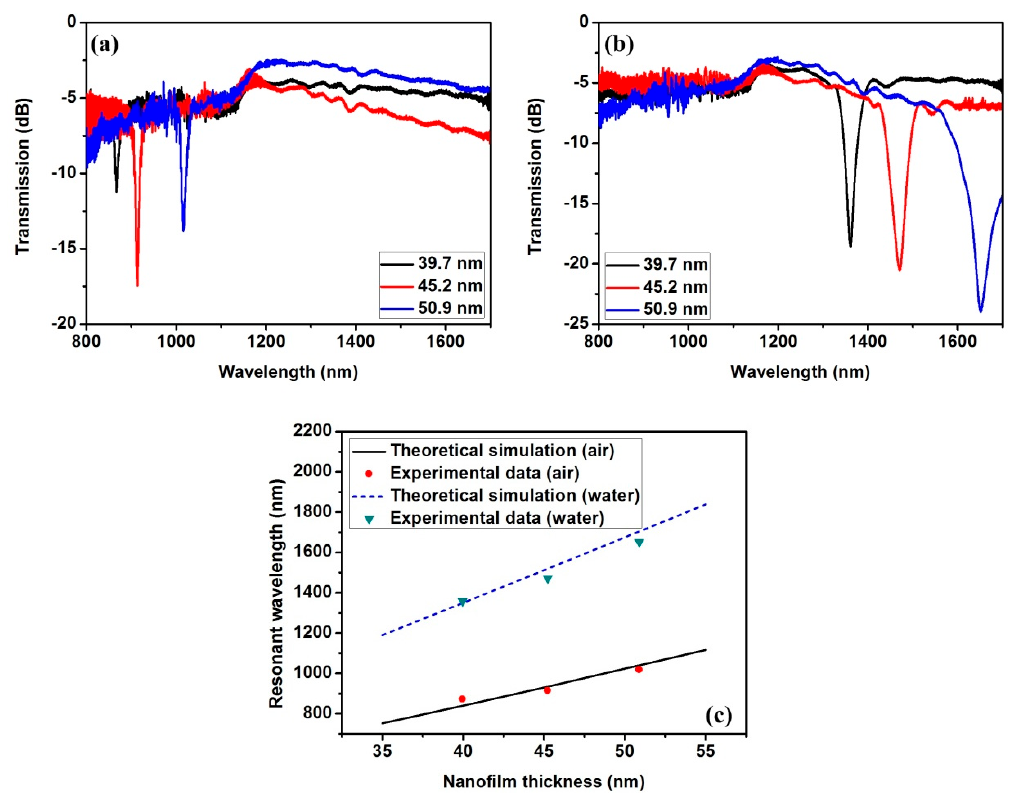
Figure 6. Transmission spectra obtained when the tapered fiber with TiO 2 thicknesses of 39.7, 45.2, and 50.9 nm are immersed in ( a ) air and ( b ) deionized water; and ( c ) resonant wavelength as a function of the TiO 2 film thickness.